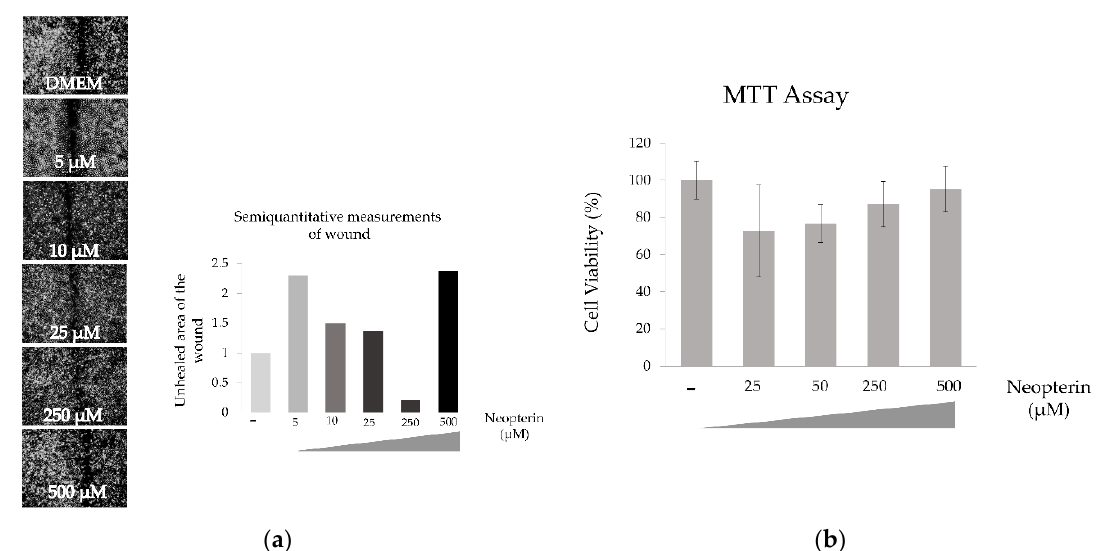
Figure 4. Effect of neopterin on wound healing ( a ) and cytotoxicity ( b ) of SNU449 cell line.